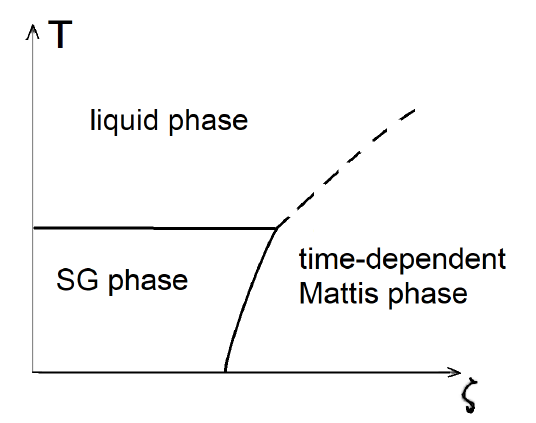
Figure 6: A sketch of the ζ - T phase diagram.